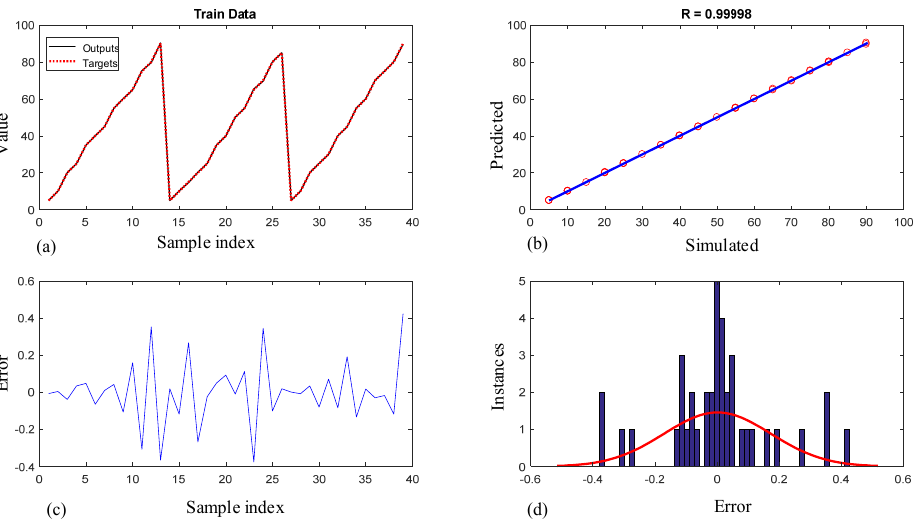
Figure 13. Outcomes of the training process for void fraction measurement: ( a ) fitting, ( b ) regression, ( c ) error, ( d ) error histogram diagram.